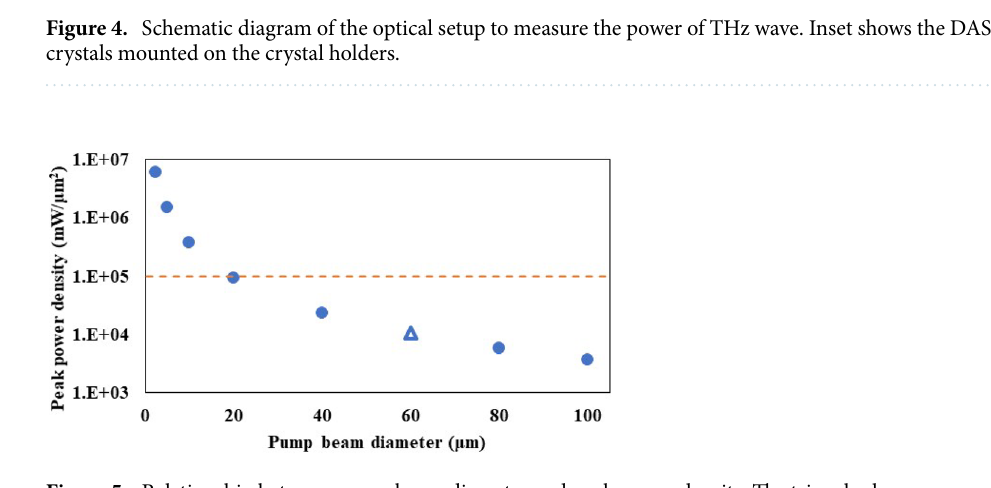
Figure 5. Relationship between pump beam diameter and peak power density. The triangle shows an experimental value in this study. Power density of 10 5 mW/μm 2 is shown by a dotted line for a